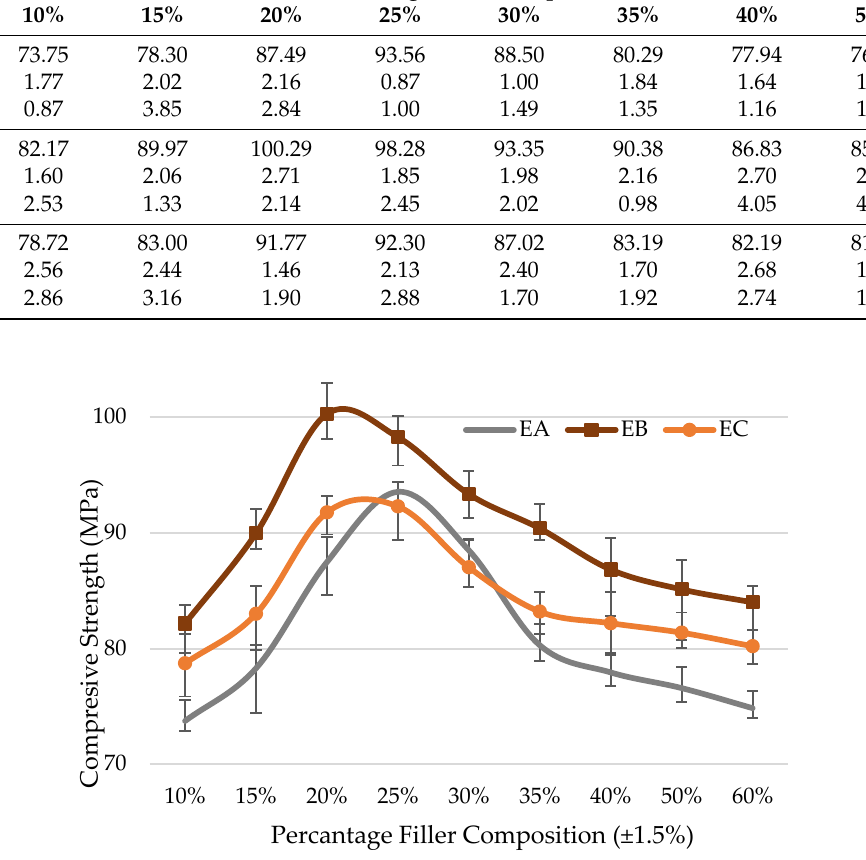
Figure 14. Effects of fillers on compressive strength.